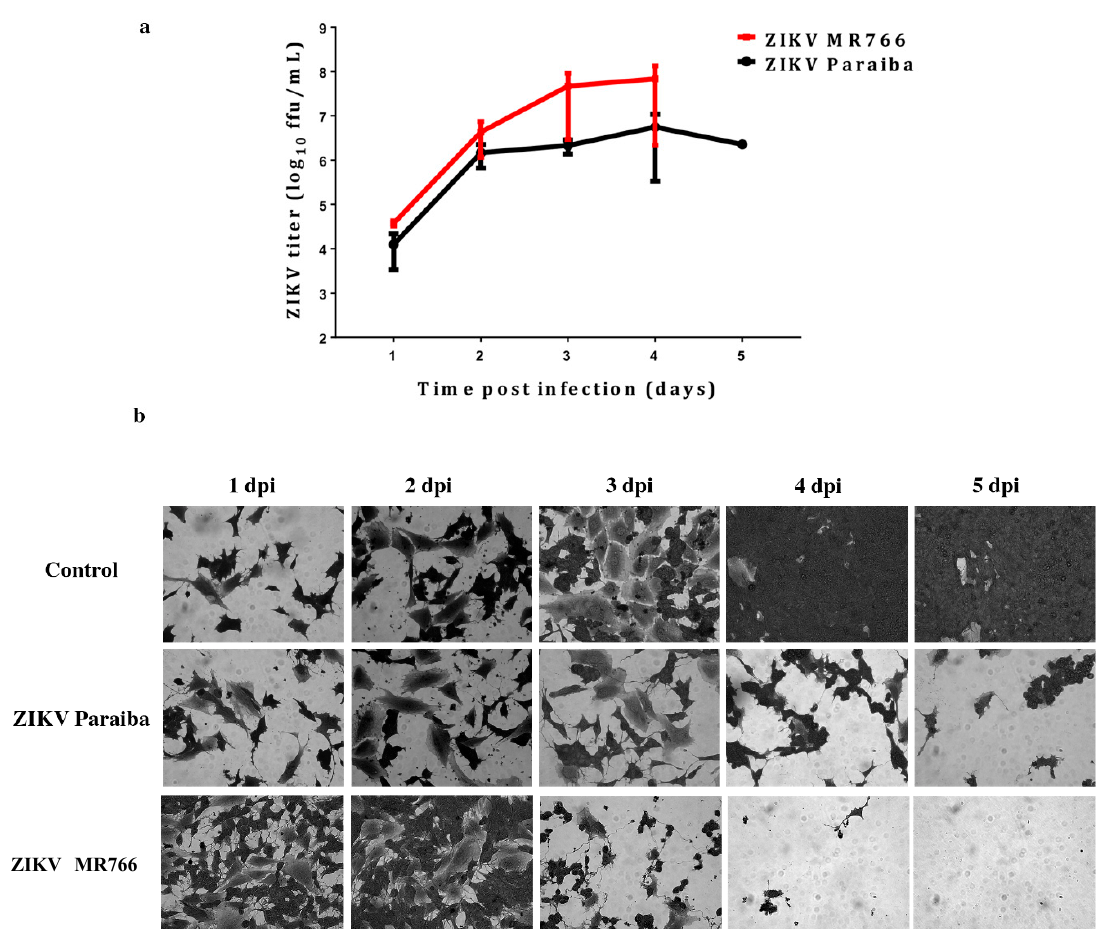
Figure 6. ZIKV infection in a human neuroblastoma SK-N-SH cell line. ( a ) Replication kinetics of ZIKV MR766 and Paraiba strains in SK-N-SH cells. Error bars represent SD from the mean for 3 independent experiments. ( b ) Cell death in SK-N-SH cell monolayers infected with ZIKV Paraiba or ZIKV MR766. ZIKV MR766 was more aggressive at killing SK-N-SH cells. Images of the SK-N-SH monolayer were acquired at a magnification of 400×.